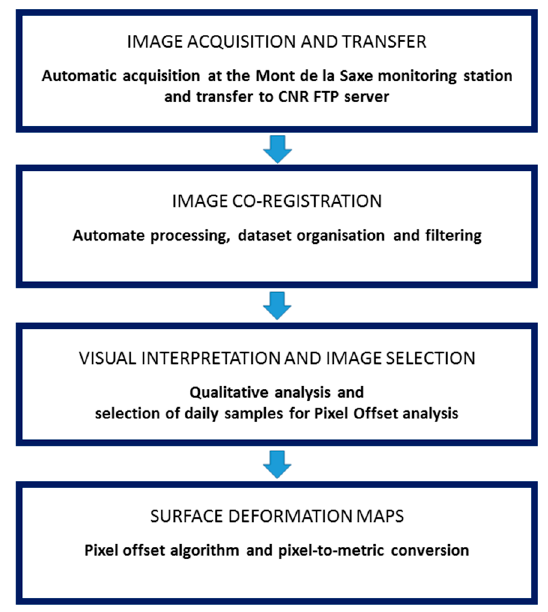
Figure 4. Work flow of the image processing.